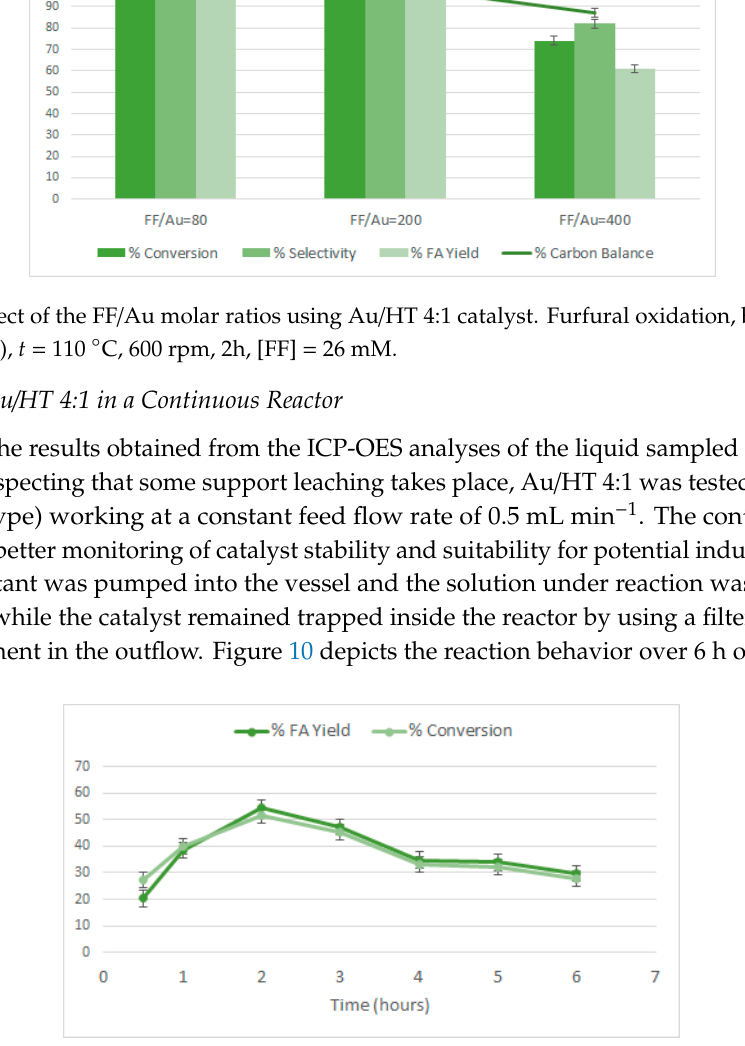
Figure 8. Effect of the reaction temperature using Au/HT 4:1. Furfural oxidation, batch reactor, p = 6 bar (O 2 ), 600 rpm, 2 h, FF/Au = 80, [FF] = 26 mM, 63 mg of catalyst.